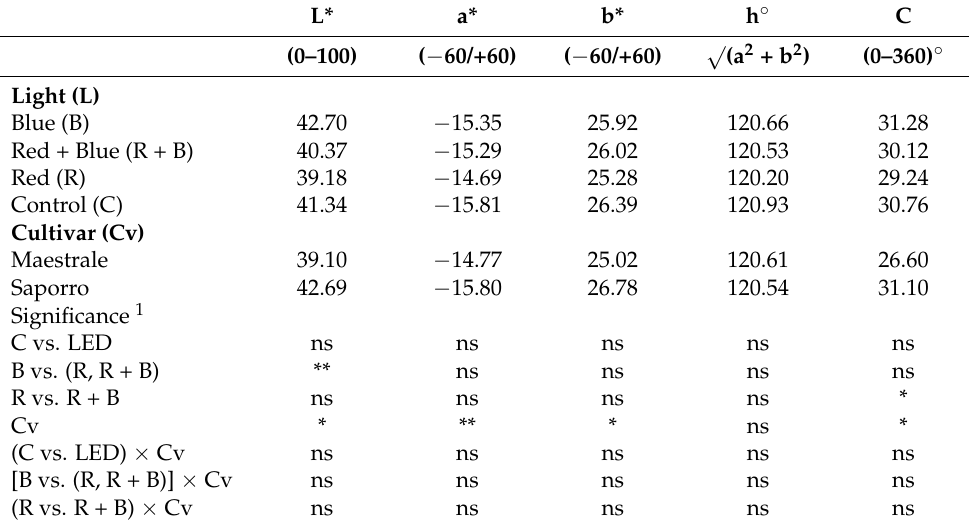
Table 2. Effects of the light spectra and cultivar on the colour parameters of pods harvested on 4